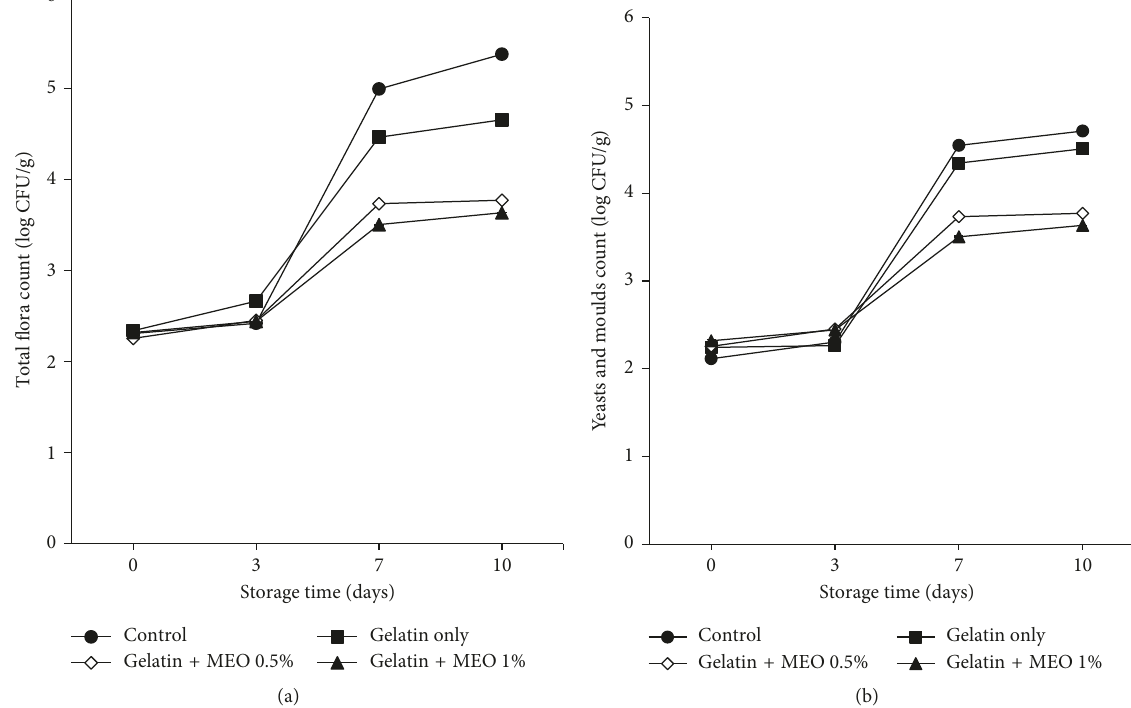
Figure 1: Total aerobic mesophilic flora (TAMF) (a) and yeast and mould (YM) (b) counts of coated and uncoated strawberries during storage at 4 ° C for 10 days. Vertical bars represent the standard deviation ( n �